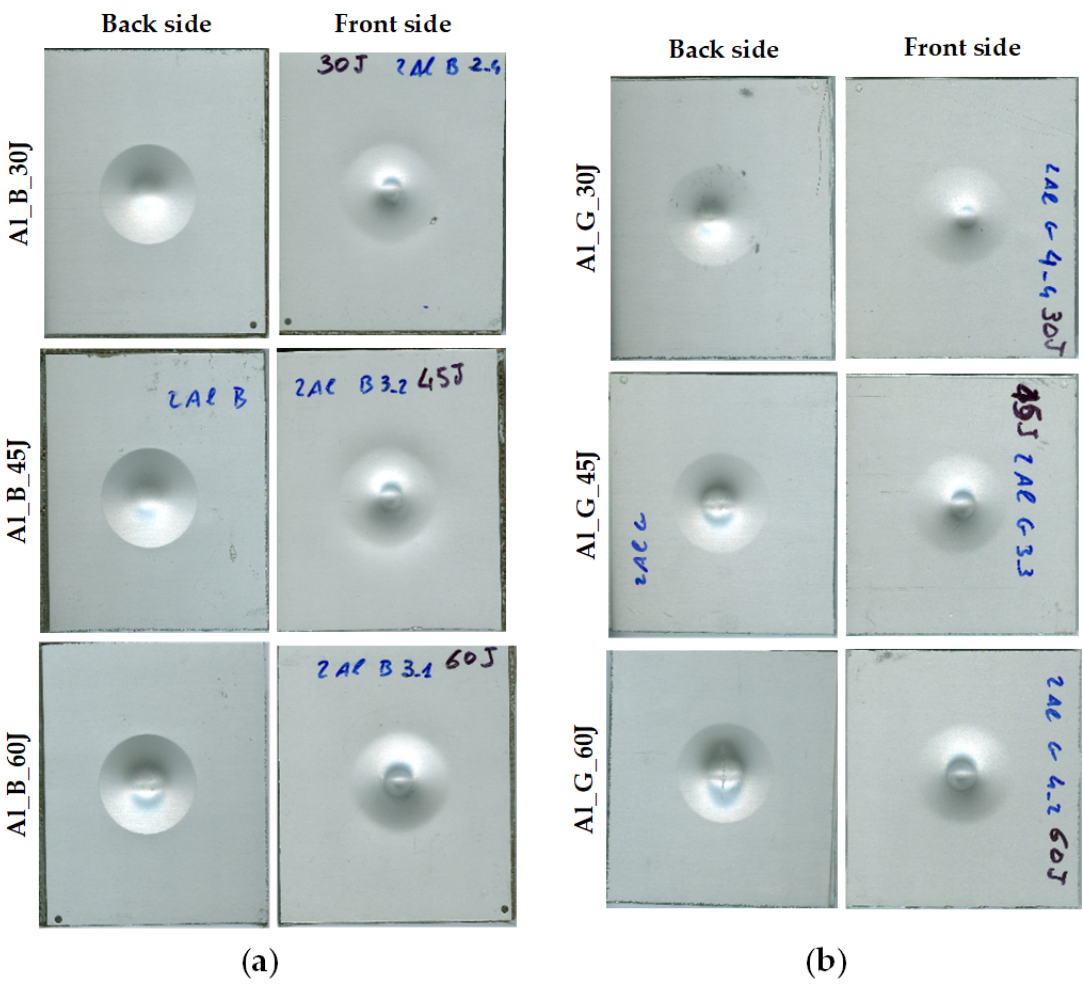
Figure 2. Photographs of the six samples: ( a ) Aluminium ‐ BFRP hybrid composites; ( b ) Aluminium ‐ GFRP composites.